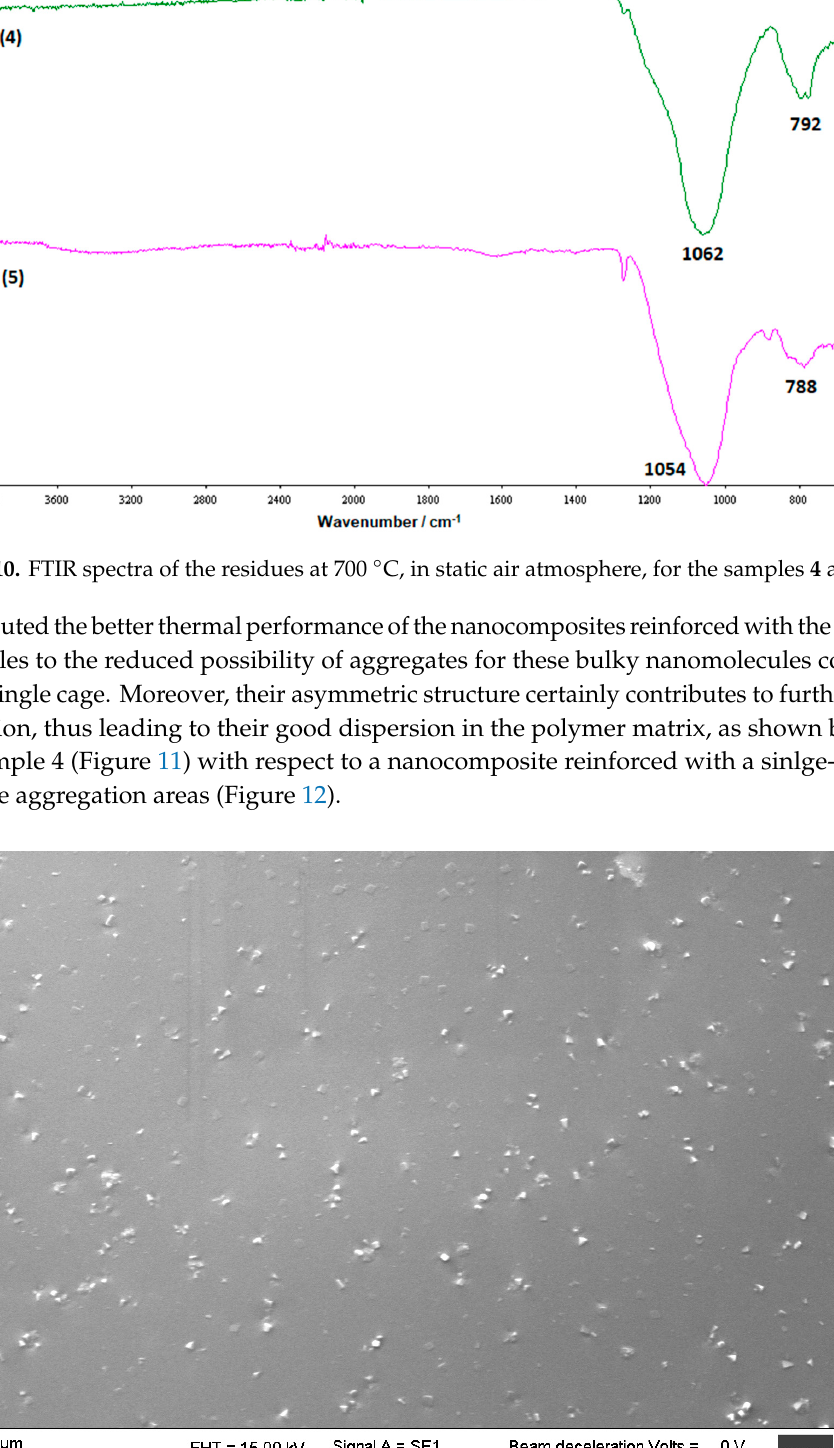
Figure 12. SEM micrographs of sample 1 .